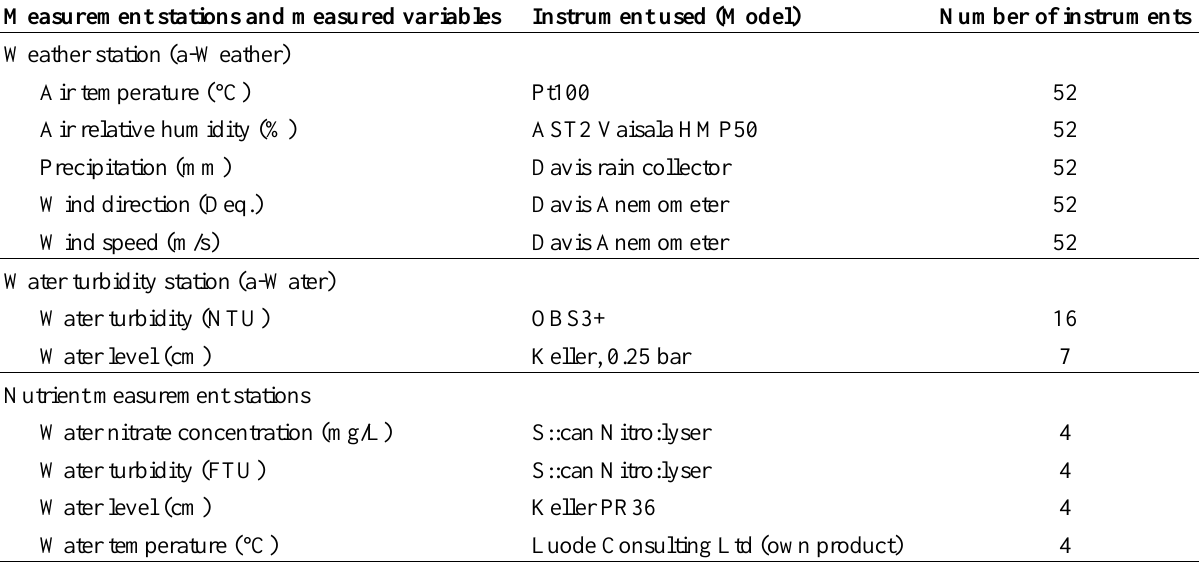
Table 1. Variables measured and sensors used in SoilWeather WSN.